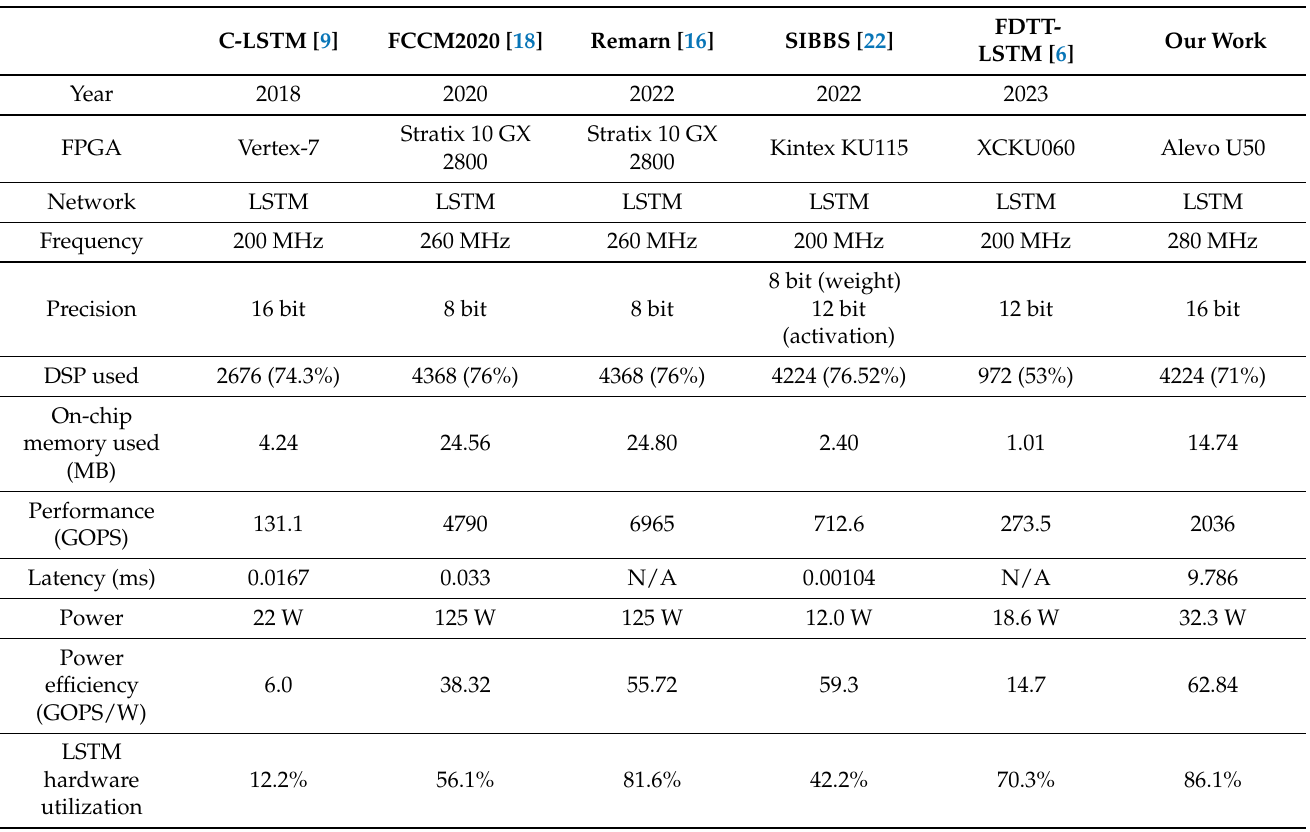
Table 6. Comparison with previous